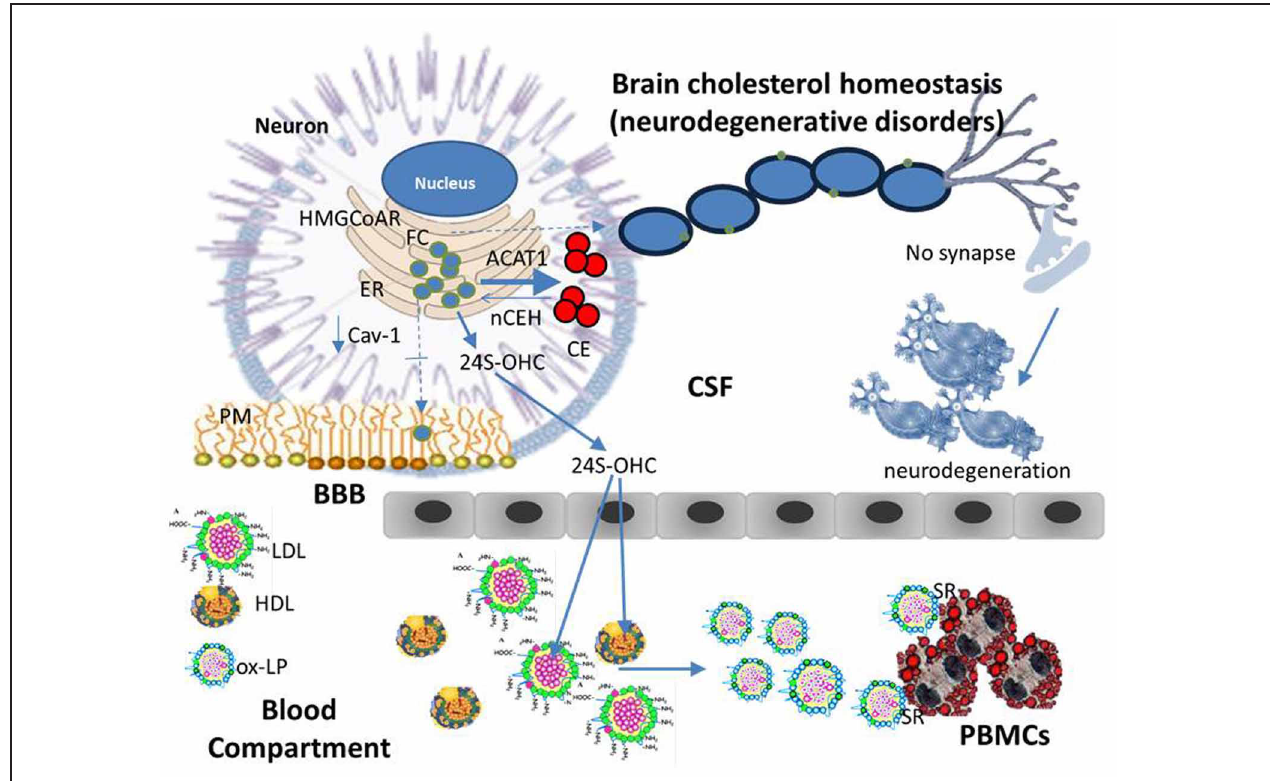
FIGURE 4 | Cholesterol homeostasis (neurodegenerative disorders). An imbalance of one or more of finely regulated homeostatic mechanisms that lead to even modest changes in ER-FC pool in neurons can cause a serious and sometimes fatal neurologic disorder. Namely, if a reduction in the transport of cholesterol between ER and PM occurs as a consequence of genetic and/or environmental factors, neuronal ER-FC increases. This increase may cause the activation of ACAT1 leading to an increased CE synthesis while reducing the distribution of FC in raft-domains. If these alterations persist over time